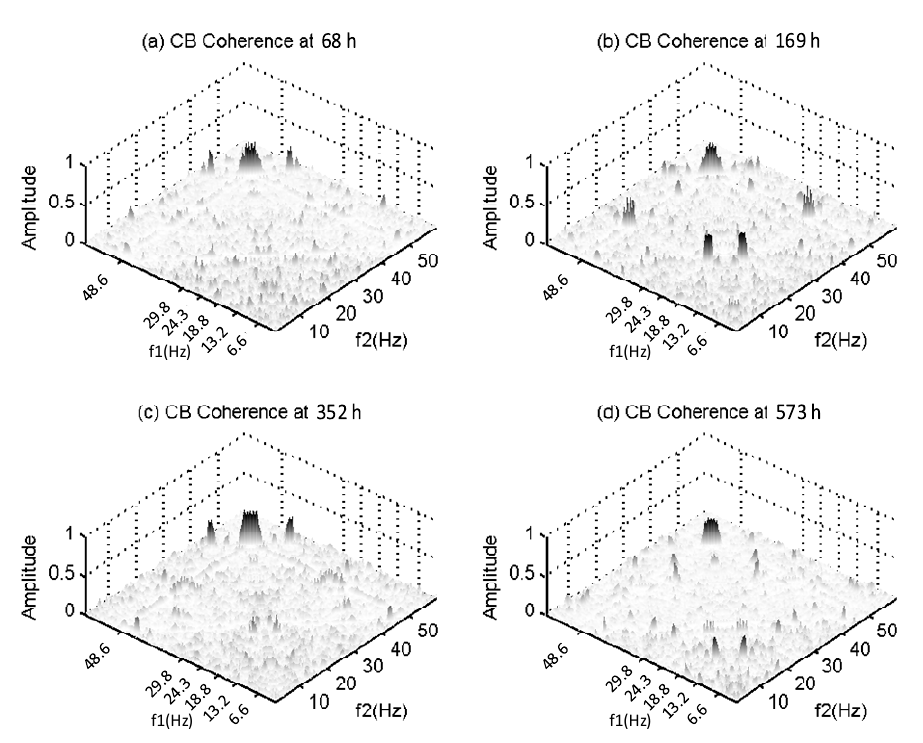
Figure 11. CB coherences for gearbox at successive time instants.